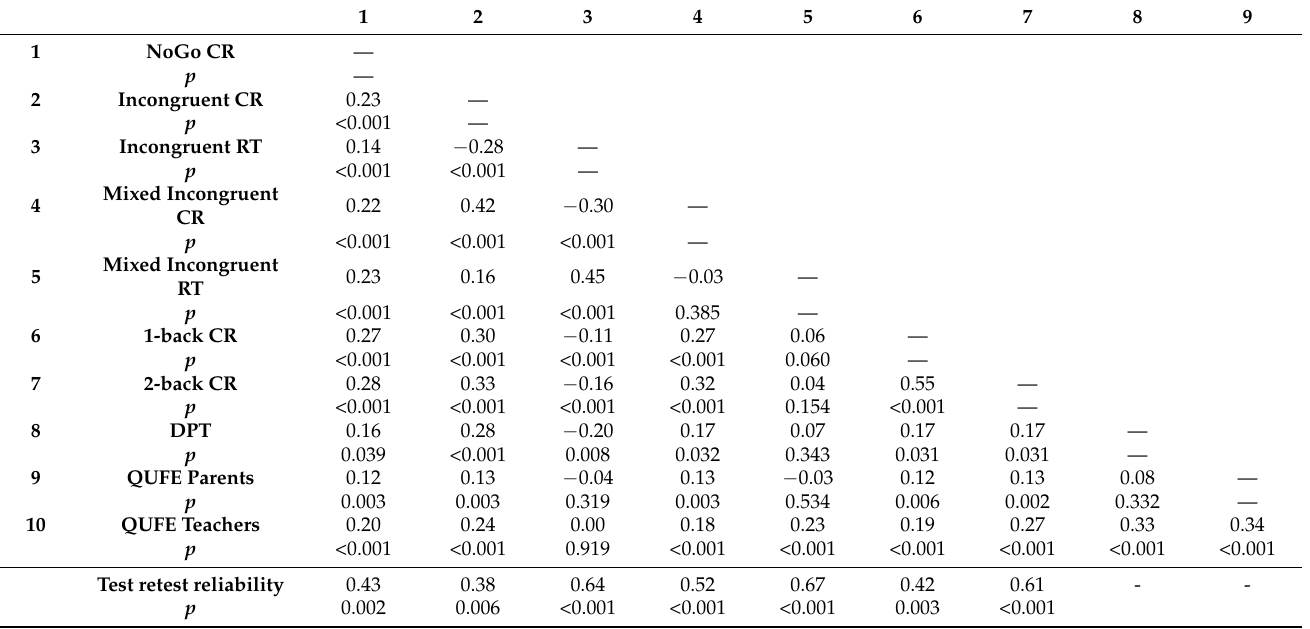
Table 2. Partial correlation between EF measures (control by age) and test–retest